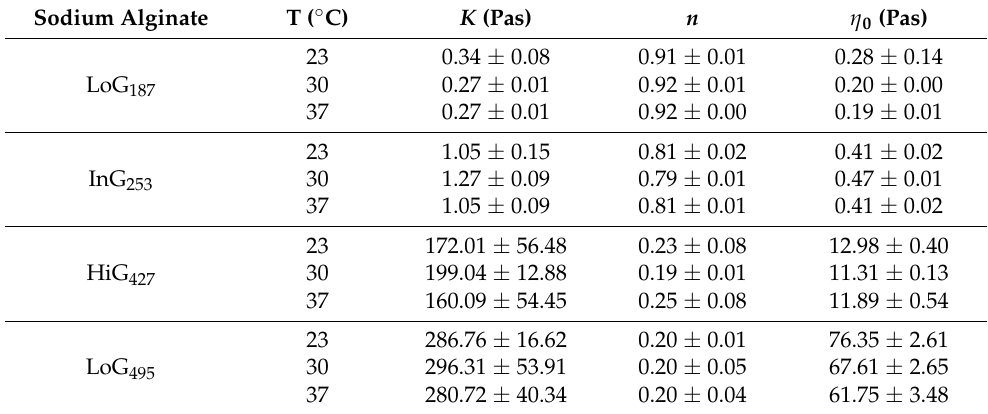
Table 2. Ostwald–de Waele parameters and zero-shear viscosity for all sodium alginates in aqueous solution at 4% ( w / w ) and three different temperatures. Sodium